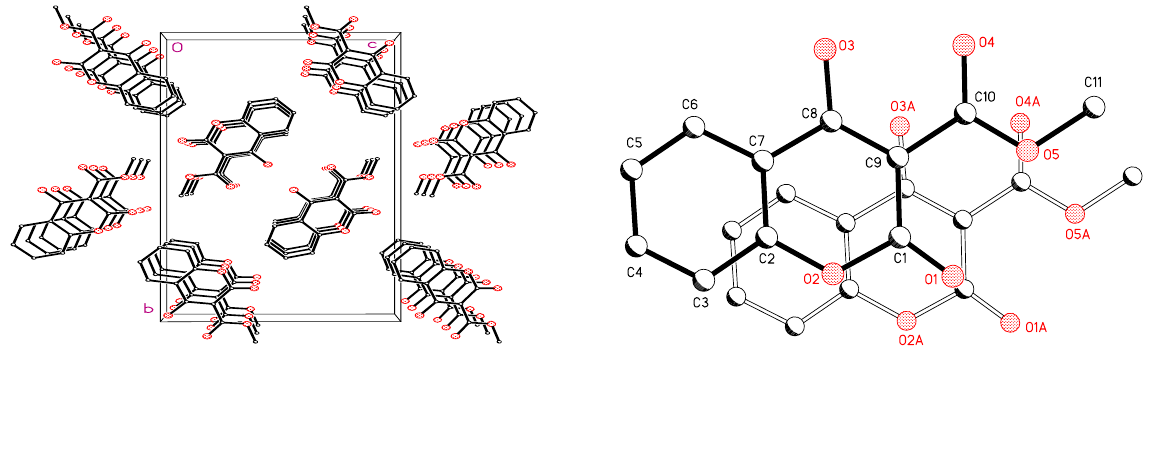
Figure 5. Packing diagram of 4-hydroxy-3-methoxycarbonyl coumarin